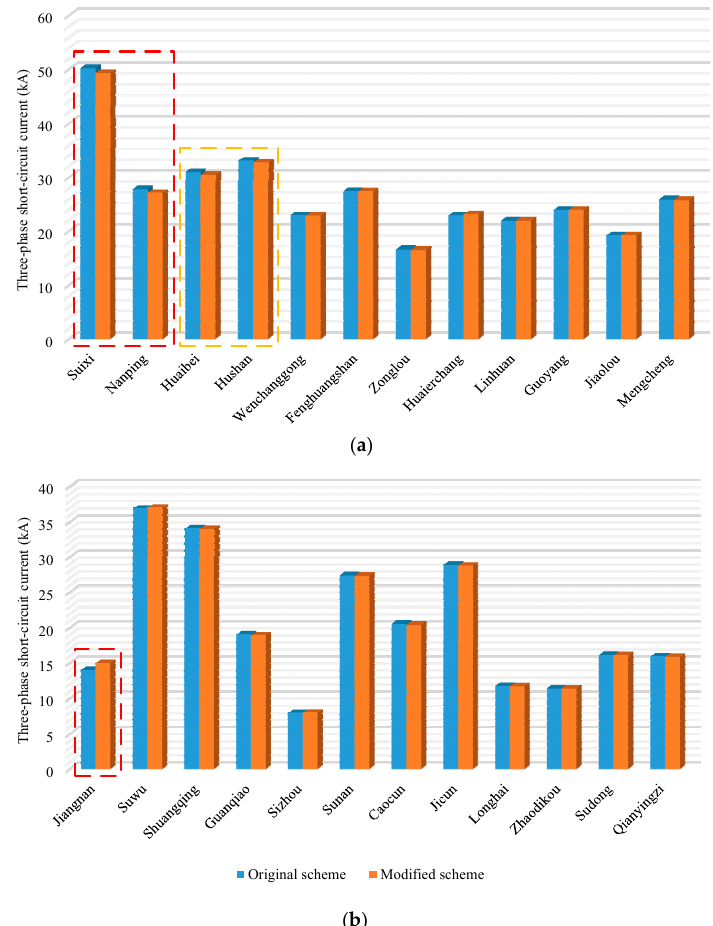
Figure 20. Comparison of initial AC component values of Huaisu power grid. ( a ) short-circuit current of substations (from Suixi to Mengcheng); ( b ) short-circuit current of substations (from Jiangnan to Qianyingzi).